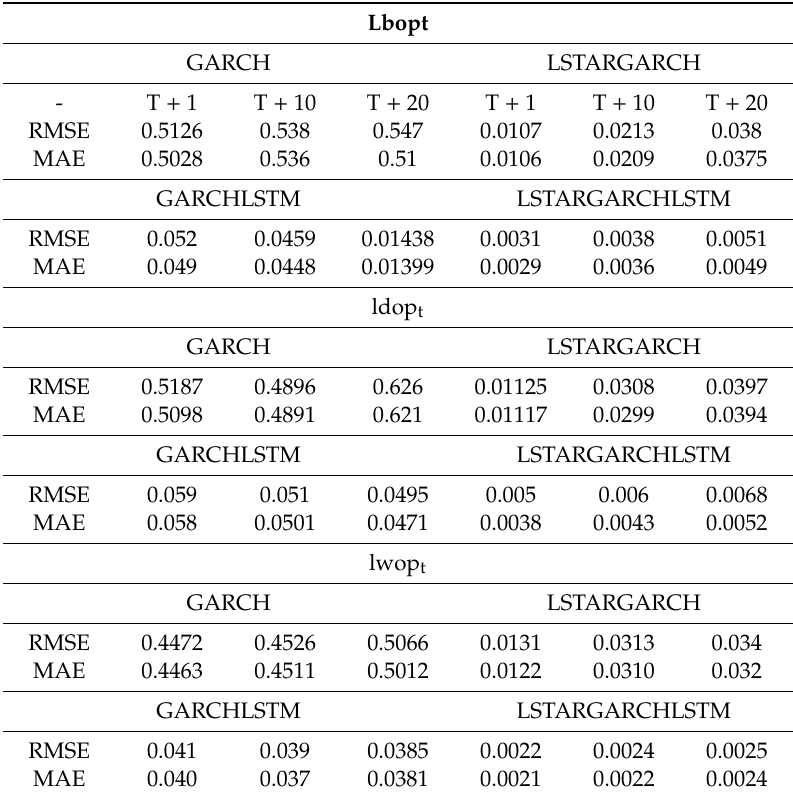
Table 9. Out of sample forecast results 1, 10 and 20 days